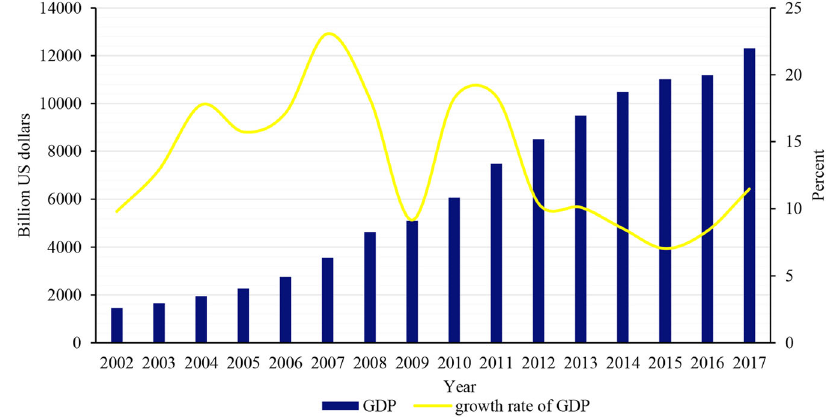
Fig. 1 China ’ s GDP and its growth rate from 2002 to 2017.